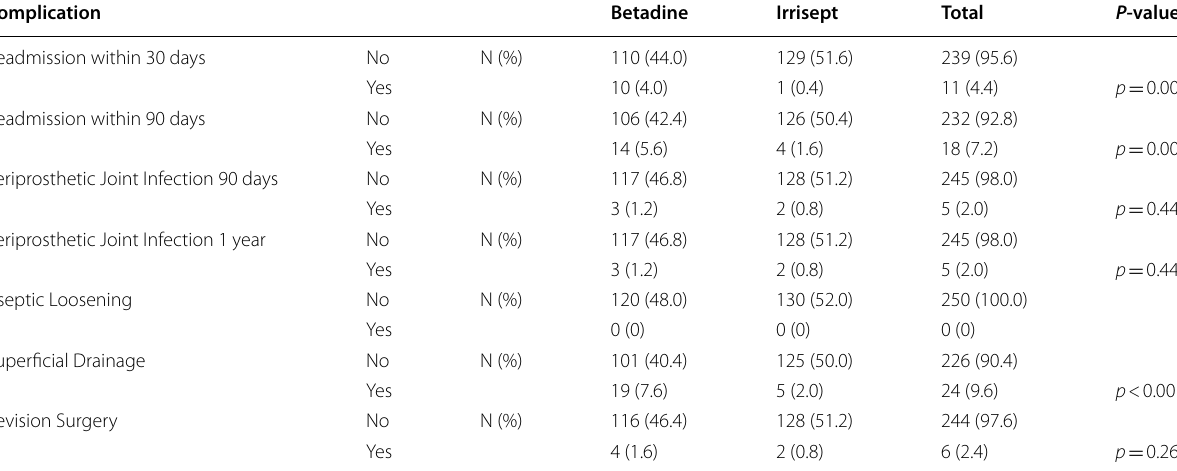
Table 4 Complication rates for betadine versus CHG lavage: total knee arthroplasty